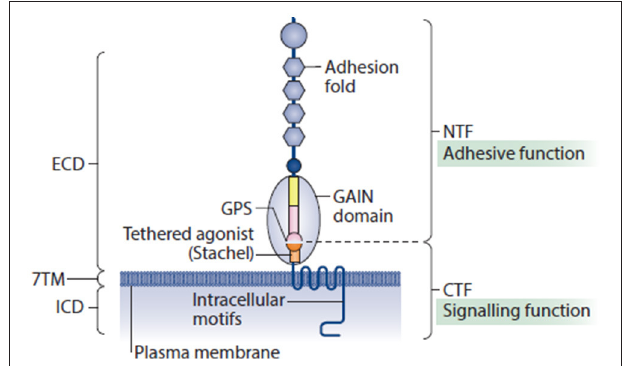
FIGURE 3 | Adhesion G protein-coupled receptors possess structural elements of adhesion molecules and GPCRs. Their extended extracellular domain (ECD) usually contains a collection of adhesion motifs that can engage with cellular and matricellular interaction partners, and a juxtamembrane GPCR autoproteolysis-inducing (GAIN) domain, which is present in all aGPCRs. GAIN subdomain A (yellow rectangle), GAIN subdomain B (pink rectangle) and the GPCR proteolysis site (GPS) motif (pink and orange semicircles) are shown. The GAIN domain is directly connected to the seven-transmembrane (7TM) unit through a linker sequence of approximately 20 amino acids, known as the Stachel (stalk). Recently, this structural component of aGPCRs was identified as a tethered agonist, which stimulates metabotropic activity of several aGPCR homologs. Similar to the ECD, the intracellular domains (ICDs) of aGPCRs can be unusually large. It is estimated that more than one-half of all known aGPCRs undergo auto-proteolytic cleavage that is catalyzed through the GAIN domain, which is present on the cell surface as a non-covalent heterodimer between an amino-terminal fragment (NTF) and a carboxy-terminal fragment (CTF). The cleavage occurs at the evolutionarily highly conserved GPS. Reprinted by permission from Macmillan Publishers Ltd: (Langenhan et al.,